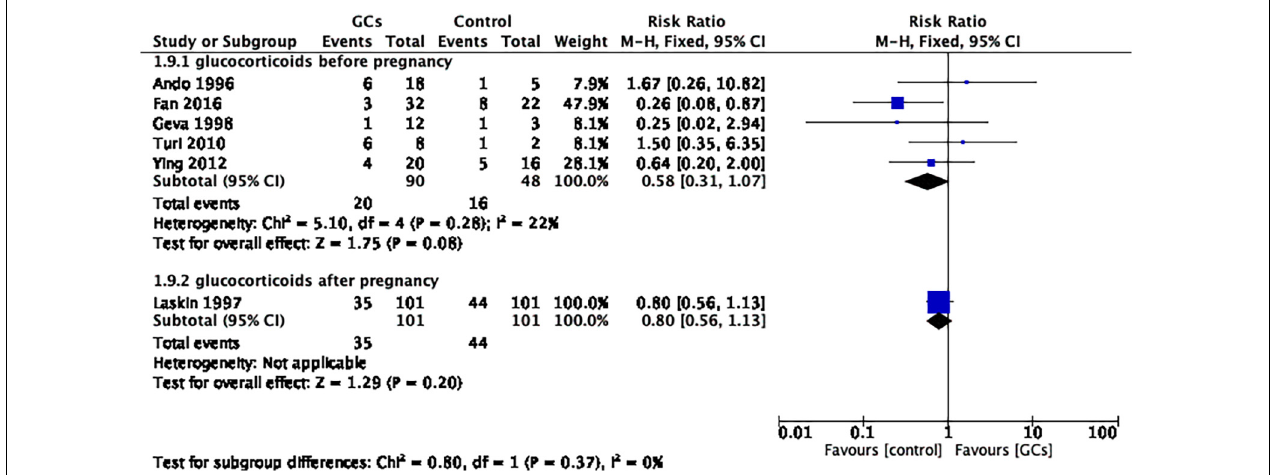
FIGURE 8 | Forest plot for comparison: glucocorticoids versus no glucocorticoids/placebo, outcome: III. II Miscarriage rate per clinical pregnancy in subgroups by the time of treatment. Six studies were divided into two subgroups according to initial treatment time, and the same result was shown for both pre-pregnancy glucocorticoid use and post-pregnancy glucocorticoid use (glucocorticoids before pregnancy: RR 0.58, 95% CI 0.31–1.07, p = 0.08, five cohort studies, 138 women, I 2 = 22%; glucocorticoids after pregnancy: RR 0.80, 95% CI 0.56–1.13, p = 0.20, one cohort study, 202 women).